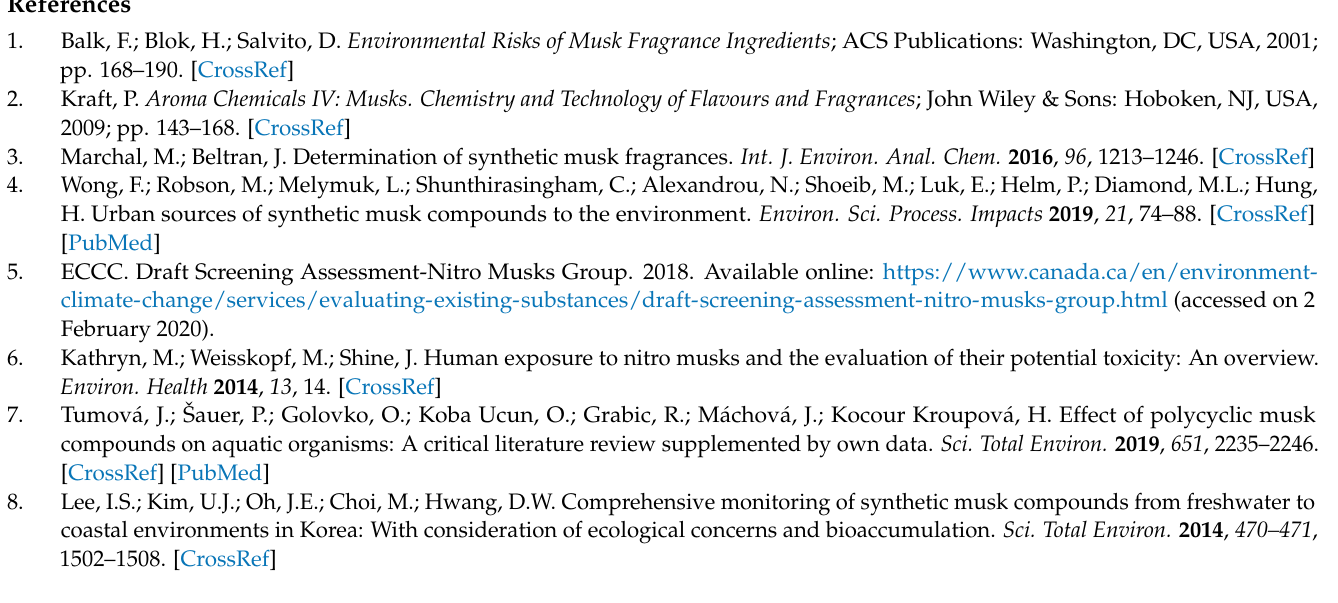
Table S3: Chromatograms and mass spectra of the SMFs, Table S4: Concentration of synthetic